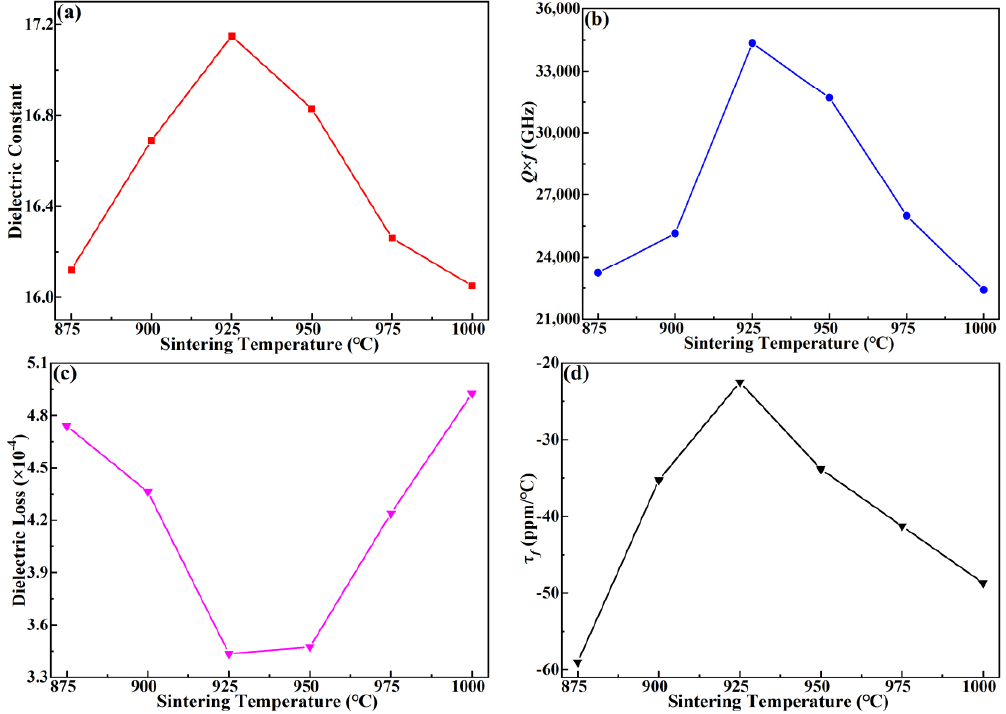
Figure 7. Microwave dielectric properties of MgCu 2 Nb 2 O 8 ceramics sintered at different tempera- tures: ( a ) ε r , ( b ) Q × f , ( c ) τ f , and ( d ) tan δ .